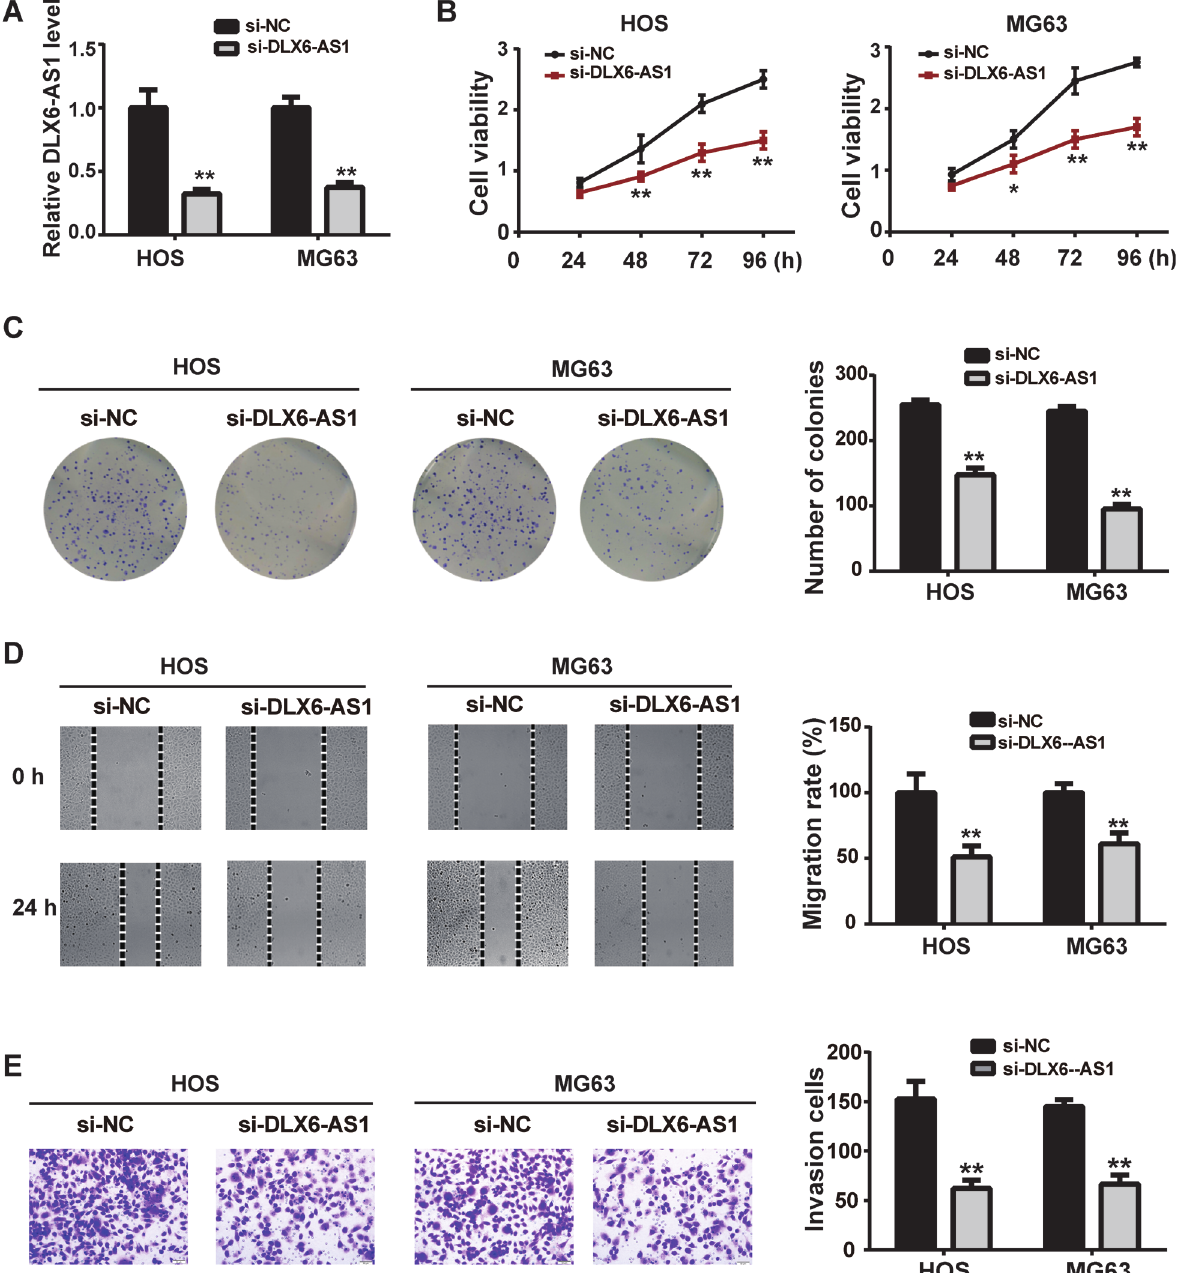
Fig. 2. Knockdown of DLX6-AS1 inhibited OS cells’ proliferation, migration and invasion. (a) Knockdown efficiency was ver- ified after si-DLX6-AS1 transfection by qPCR. (b, c) CCK-8 assay and colony formation assay was used to verify cell prolifera- tion. (d) The cell migration ability was determined via wound healing assay. (e) Transwell assay was performed to detect the cell invasion ability. NC, negative control. ** P < 0.01, versus si-NC